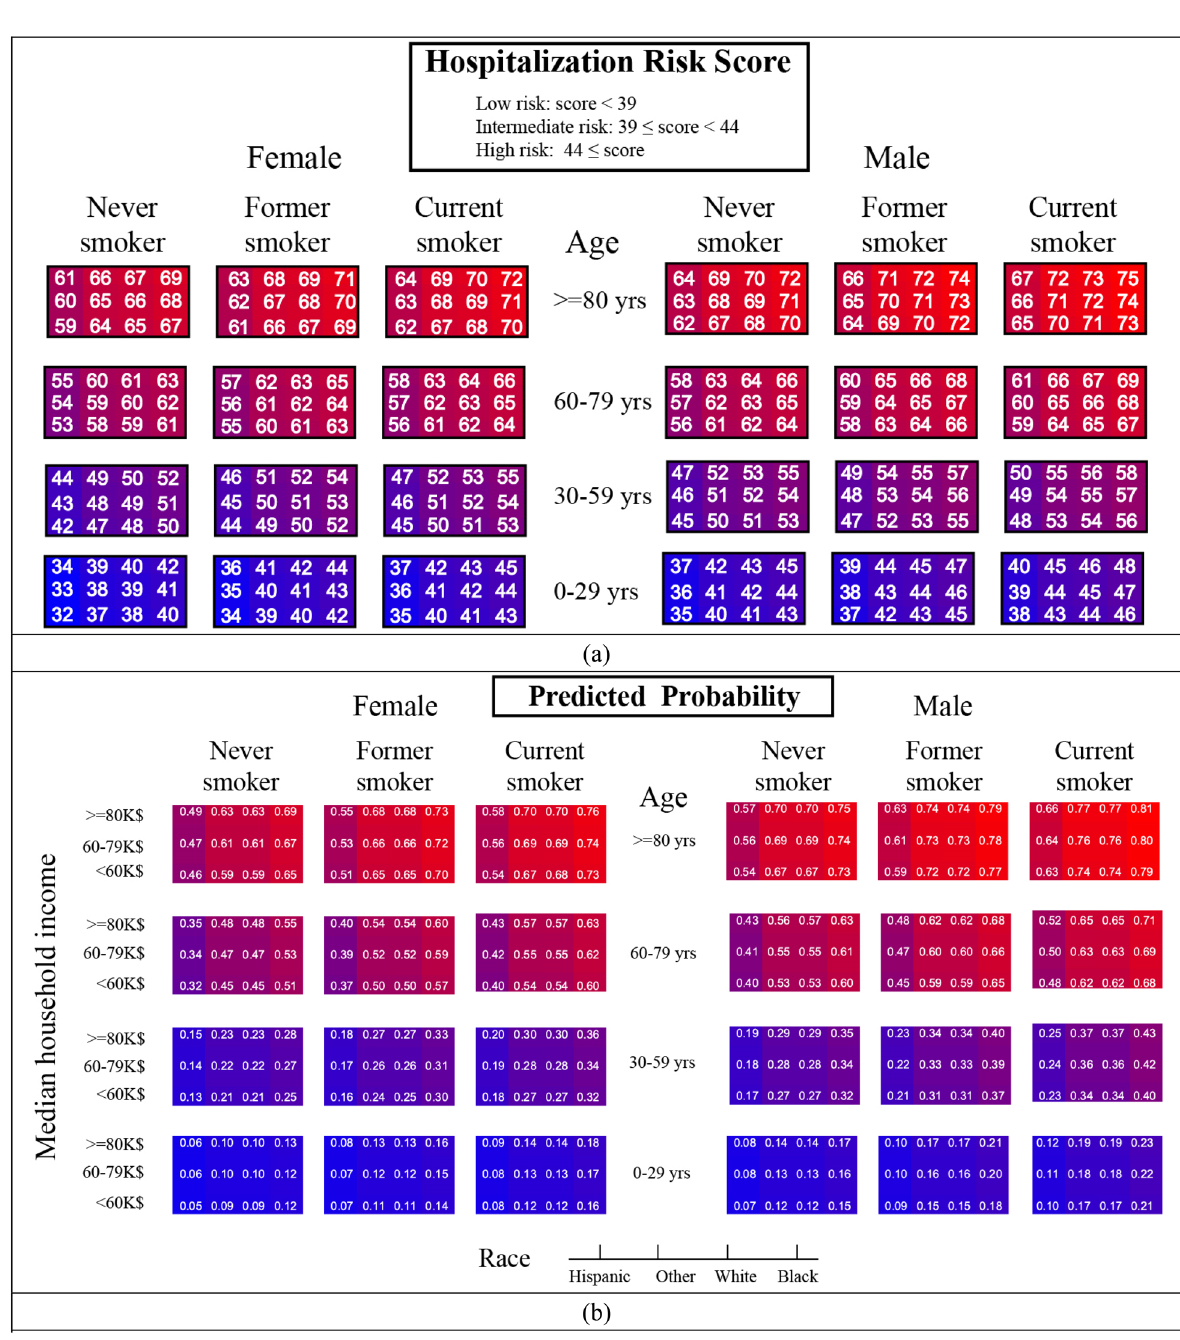
Risk groups. The optimal predicted probability cutoffs for hospitalization of patients with COVID-19 were 0.29 and 0.16, and 0.10 and 0.06 when predicting mortality among hospitalized patients. These cutoffs were used to define low, intermediate, and high-risk groups. The beta coefficients of the model were mapped according to 1 unit change that rescaled risk scores for hospitalization to 32–75 and 86–148 for mortality among hospital-